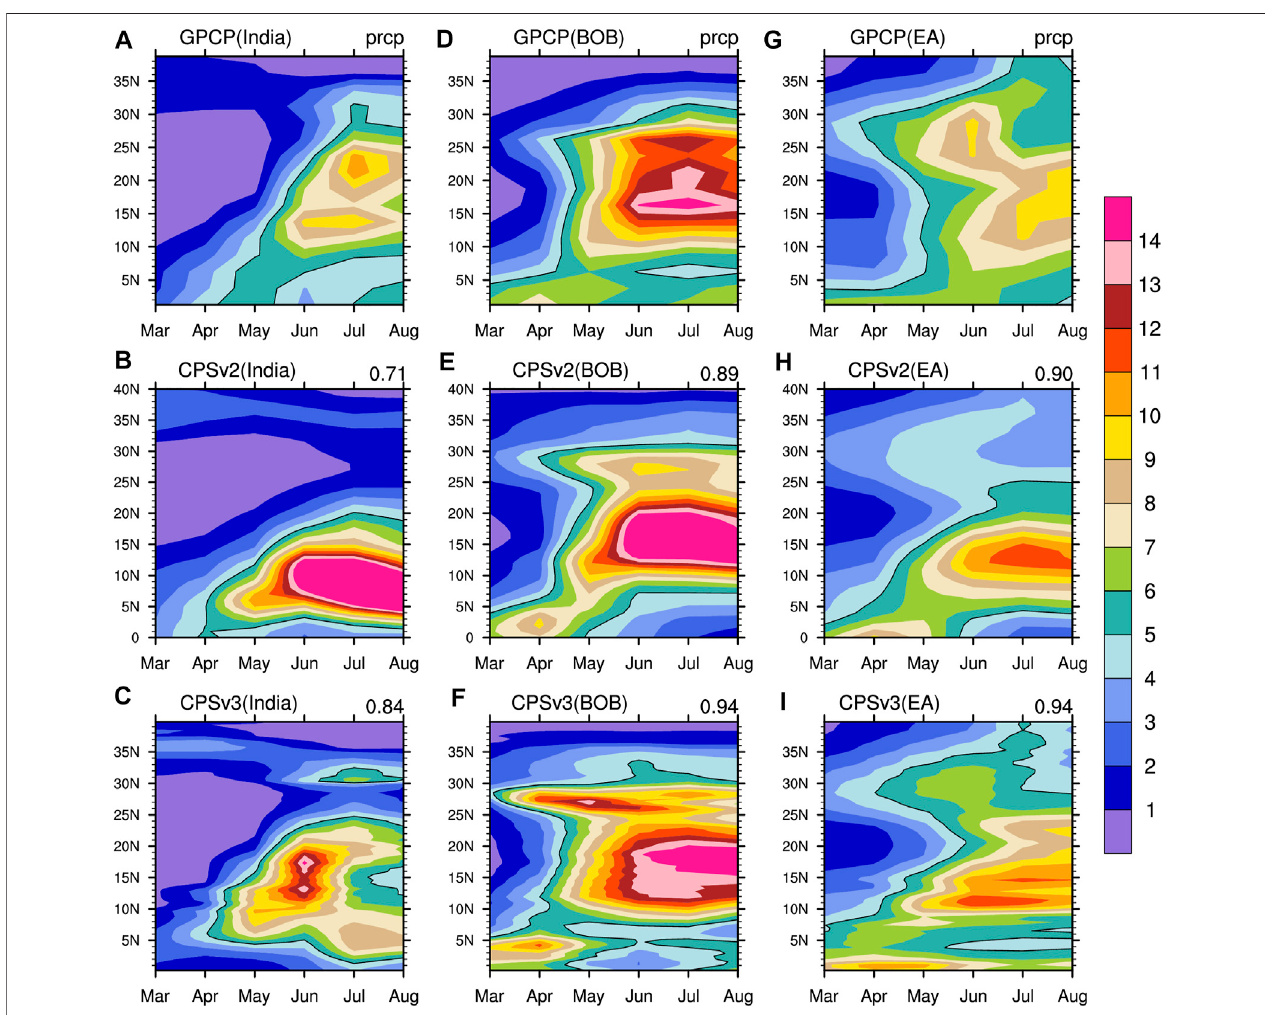
FIGURE 3 | Time – latitude sections of climatological precipitation (mm day − 1 ) along (A – C) 70 ° – 90 ° E, (D – F) 90 ° – 110 ° E, and (G – I) 110 ° – 130 ° E from GPCP (the top row), the CPSv2(the middle row), and the CPSv3 (the bottom row) data (digits in the upper right corner ofFiguresrepresent the patterncorrelation coef fi cients between the predicted precipitation and